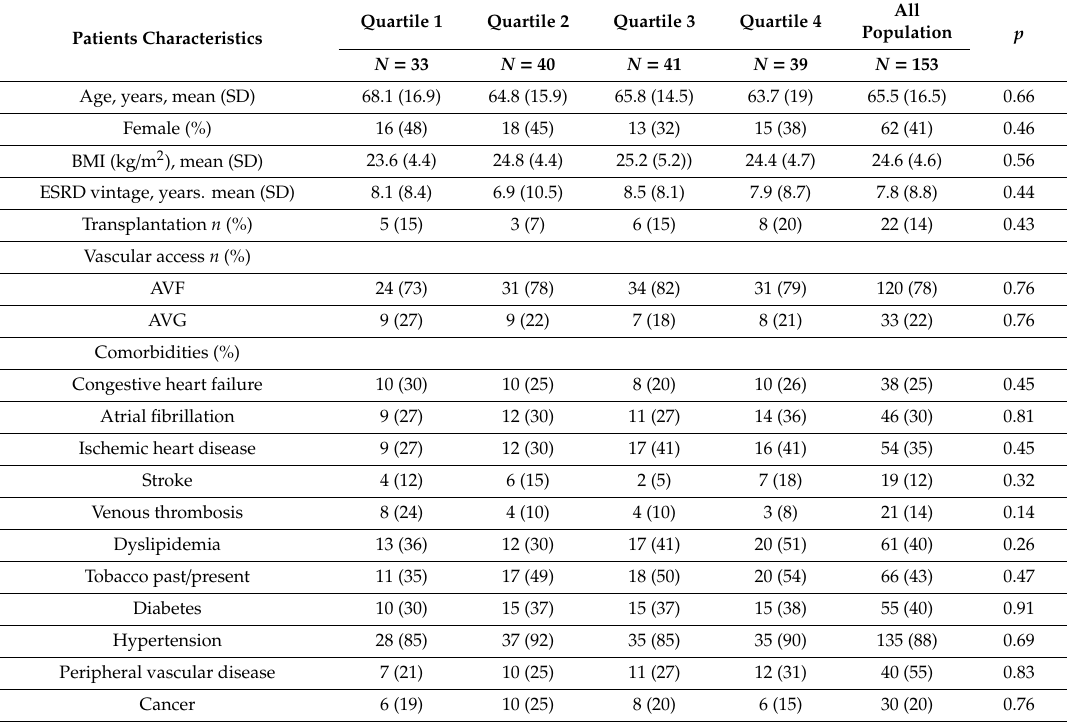
Table 1. Baseline characteristics of the cohort.